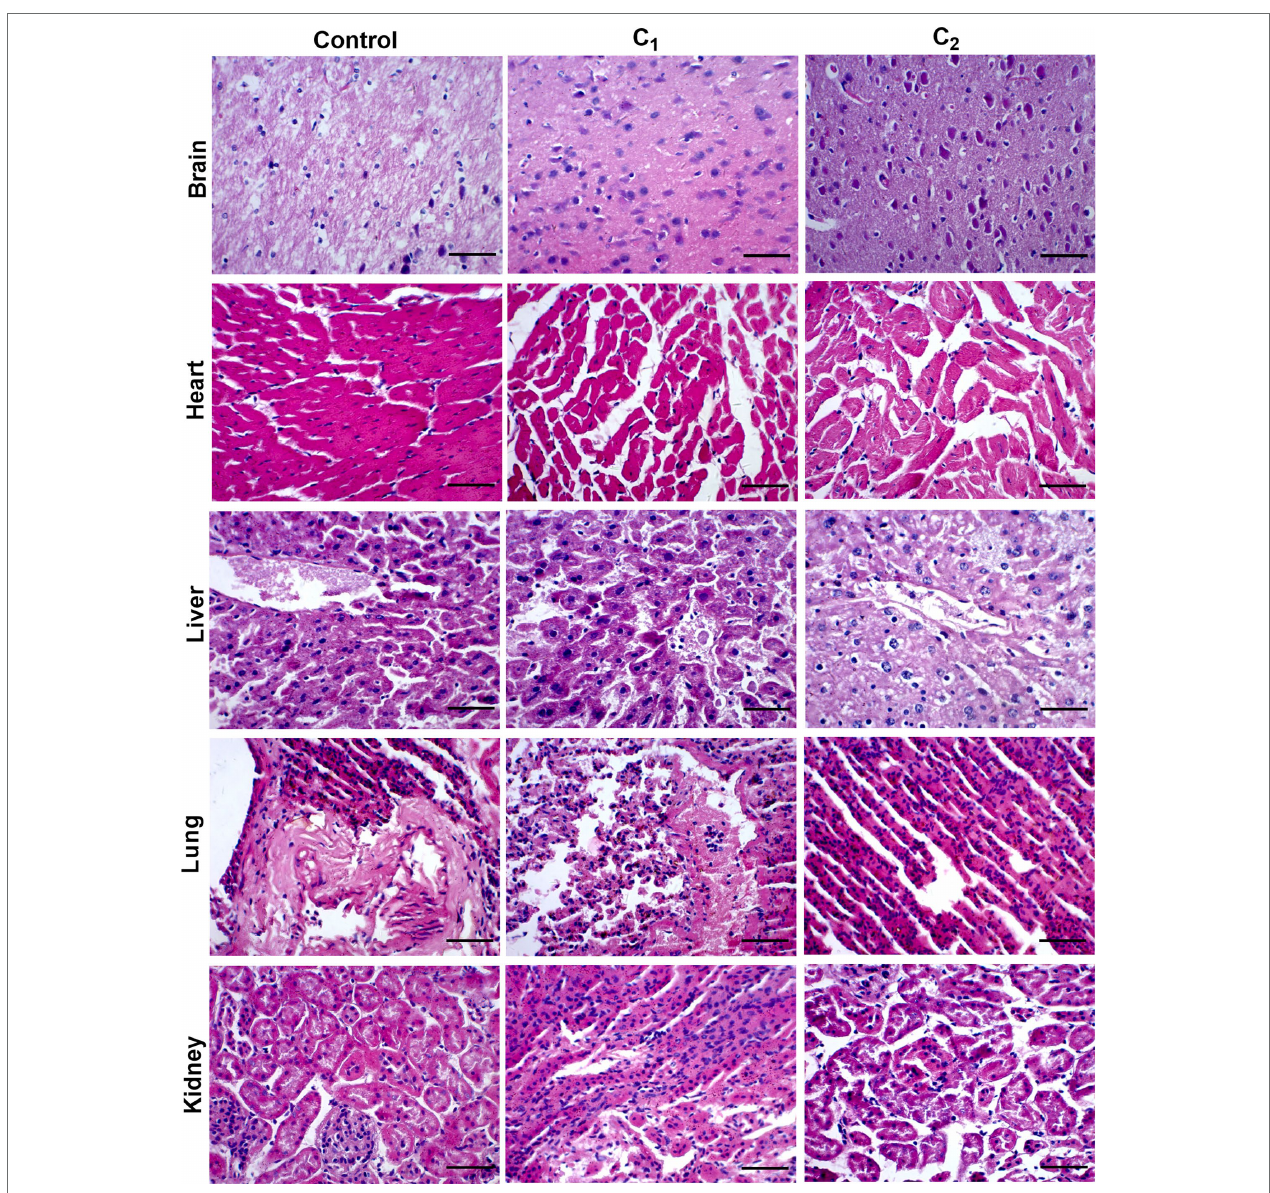
FIGURE 1 | Results of pathological tissue section: Hematoxylin staining. C 1 , Compound disinfectant 1; C 2 , Compound disinfectant 2. Bar = 20 μ